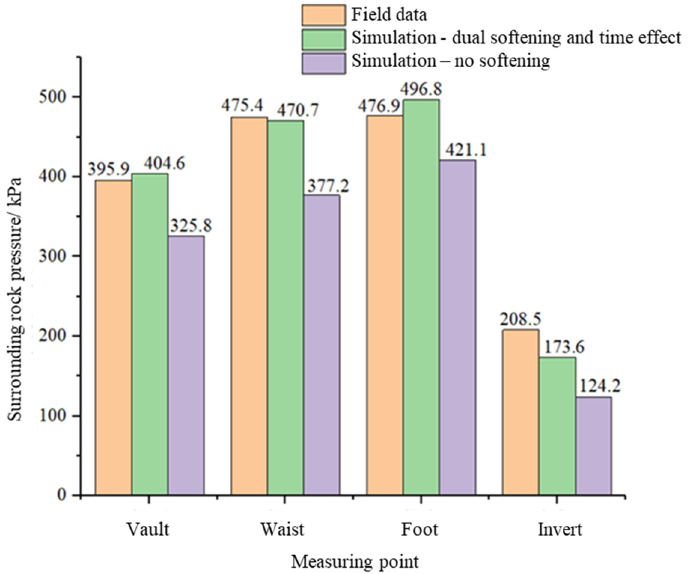
Figure 22. Field and calculated surrounding rock pressure at each measuring position.